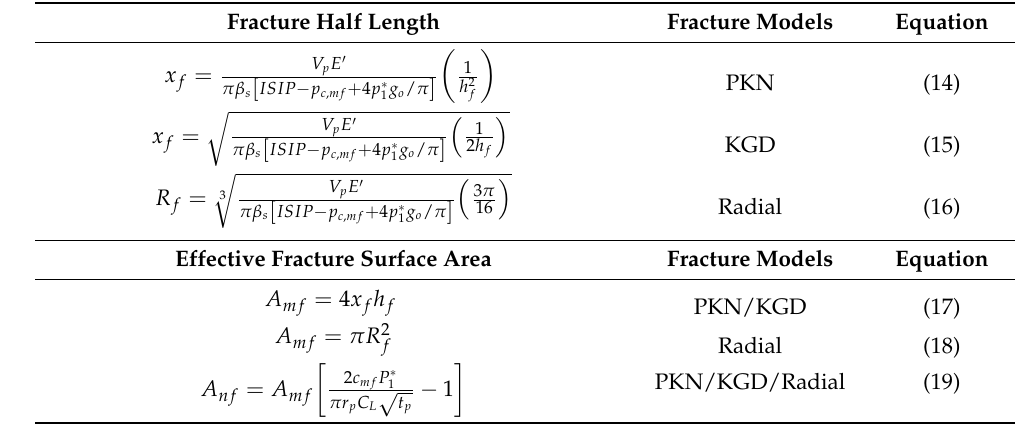
Figure 6. Workflow of research methodology to determine fracture stage performance. Table 10. Hydraulic fracture geometry